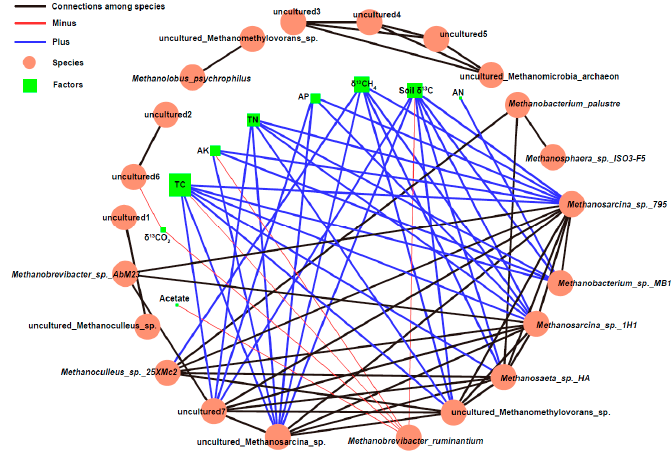
Figure 5. Co-occurrence networks. Acetate, soil acetate. δ 13 CO 2 , the δ 13 CO 2 abundance in the whole system. TC, soil total carbon. AK, soil available potassium. TN, soil total nitrogen. AP, soil available phosphate. δ 13 CH 4 , the δ 13 CH 4 abundance in the whole system. Soil δ 13 C, soil δ 13 C abundance. AN, soil alkali-hydrolyzable nitrogen. The red lines, negative correlations. The blue lines, positive correlations. The black lines, correlations among methanogens. The thickness of lines, the value of correlations. The red circles, methanogenic species. The green square, factors. Methanobacterium palustre , Taxonomy ID 2171 in NCBI. Methanosphaera sp. ISO3-F5, taxonomy ID 1,452,353 in NCBI. Methanosarcina sp. 795, taxonomy ID 1,653,396 in NCBI. Methanobacterium sp. MB1, taxonomy ID 1,379,702 in NCBI. Methanosarcina sp. 1H1, taxonomy ID 1,882,224 in NCBI. Methanosaeta sp. HA, taxonomy ID 1,562,961 in NCBI. Methanobrevibacter ruminantium , no taxonomy ID in NCBI. Methanoculleus sp. 25XMc2, taxonomy ID 1,898,331 in NCBI. Methanobrevibacter sp. AbM23, taxonomy ID 1,452,345 in NCBI. Methanolobus psychrophilus , taxonomy ID 420,950 in